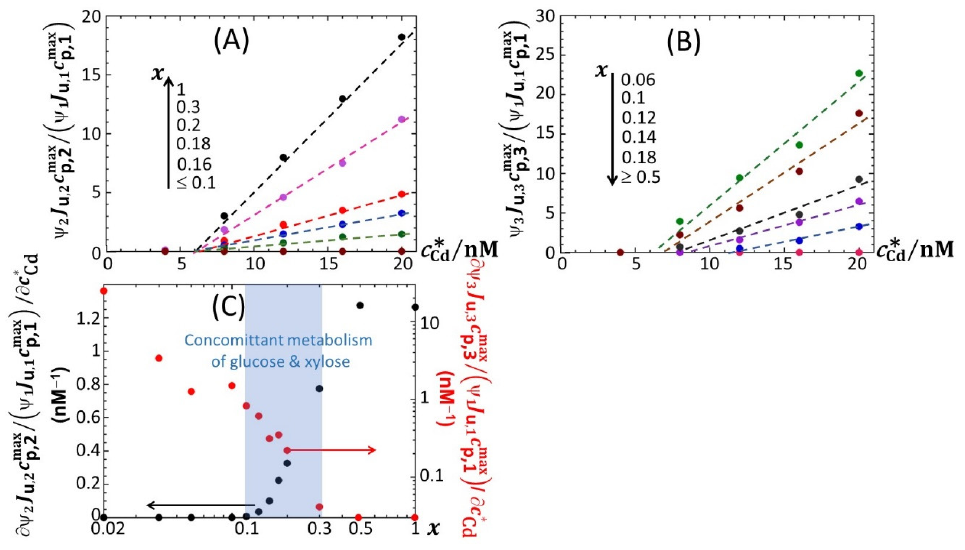
Ψ i = 2,3 J u,i = 2,3 c max p,i = 2,3 max on c ∗ for selected values of x in J c Y Ψ Cd = i 2,3 u,i=2,3 p,i=2,3 c for selected values of 1 J u,1 c max p,1 R = on * Cd i=2,3 max reported as a function of x in 0.1% J c Y Cd 1 u,1 p,1 c reported as a function of x R with * Cd i